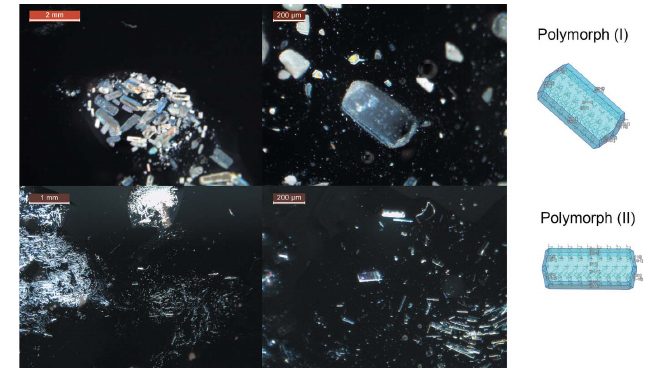
Figure 5 View of the crystal morphology of polymorph ( I ) (top) and ( II )